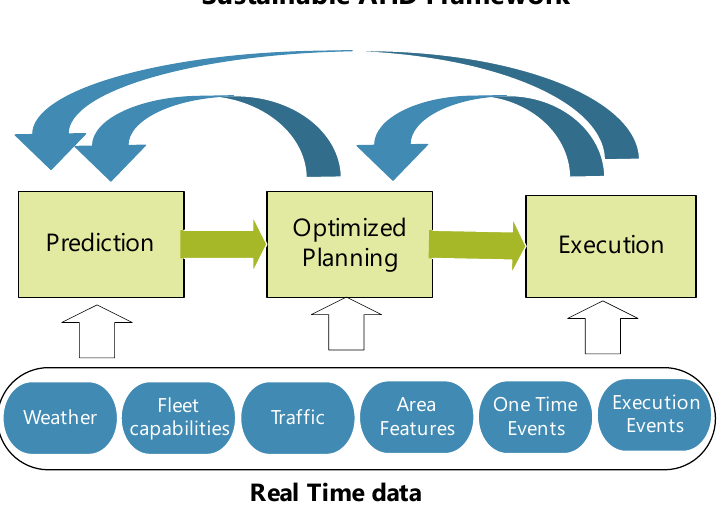
Figure 6. Real-Time Data Dependences in Sustainable AHD Framework.